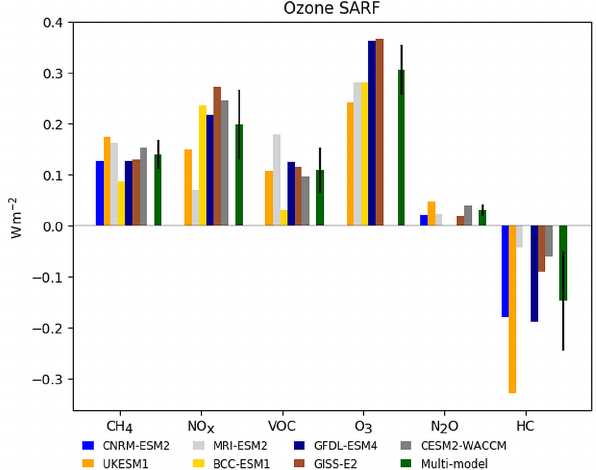
Figure 7. Changes in ozone stratospheric-temperature-adjusted ra- diative forcing (SARF) for each experiment, diagnosed using ker- nels (see text). Uncertainties for the multi-model means are standard deviations across models.